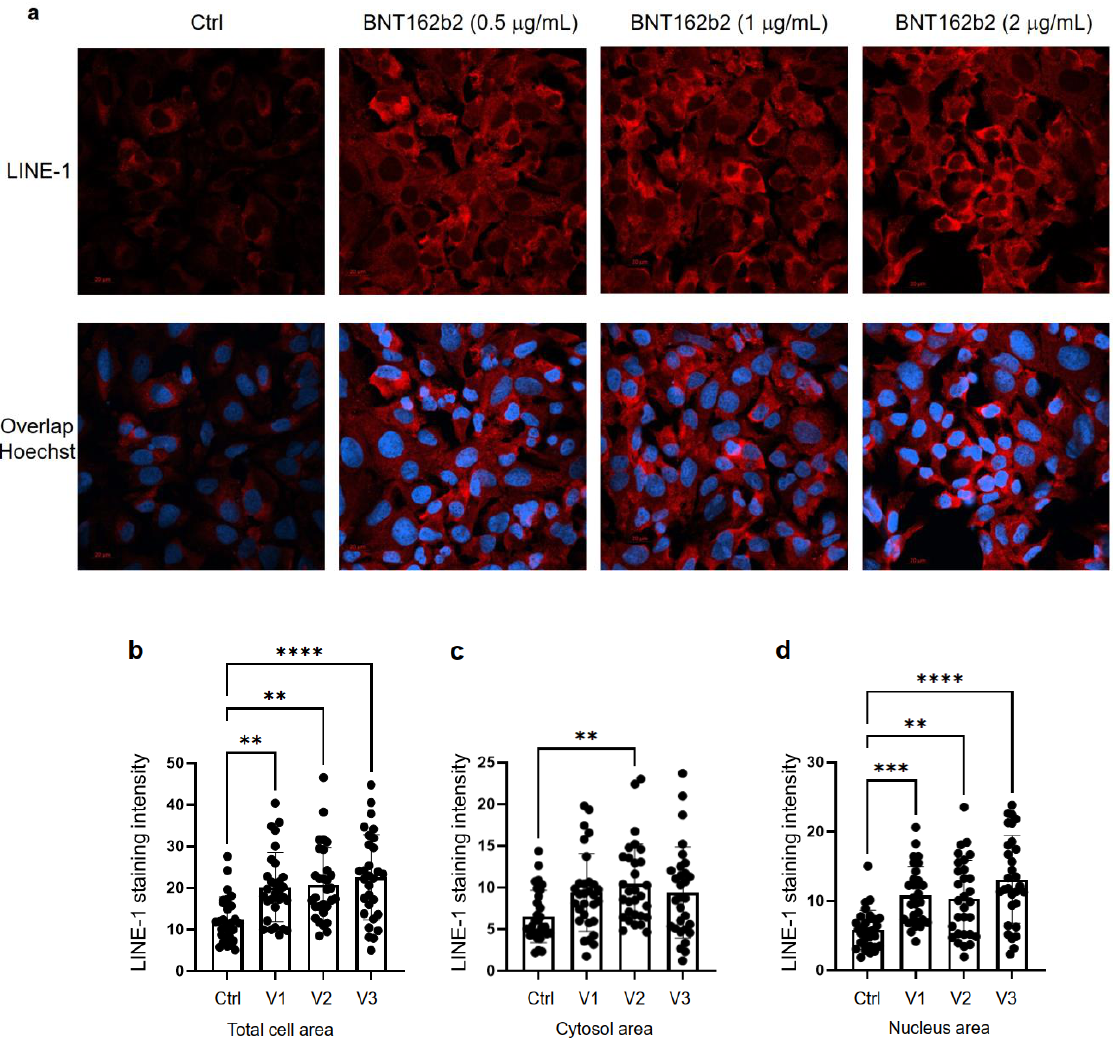
Figure 4. Immunohistochemistry of Huh7 cells treated with BNT162b2 on LINE-1 protein distribution. Huh7 cells were treated without (Ctrl) or with 0.5, 1, and 2 µ g/mL of BNT162b2 for 6 h. Cells were fixed and stained with antibodies binding to LINE-1 ORF1p (red) and DNA-specific probe Hoechst for visualization of cell nucleus (blue). ( a ) Representative images of LINE-1 expression in Huh7 cells treated with or without BNT162b2. (b – d ) Quantification of LINE-1 protein in whole cell area ( b ), cytosol ( c ), and nucleus ( d ). All data were analyzed using One-Way ANOVA, and graphs were created using GraphPad Prism V 9.2. All data is presented as mean ± SD (** p < 0.01; *** p < 0.001; **** p < 0.0001 as indicated).